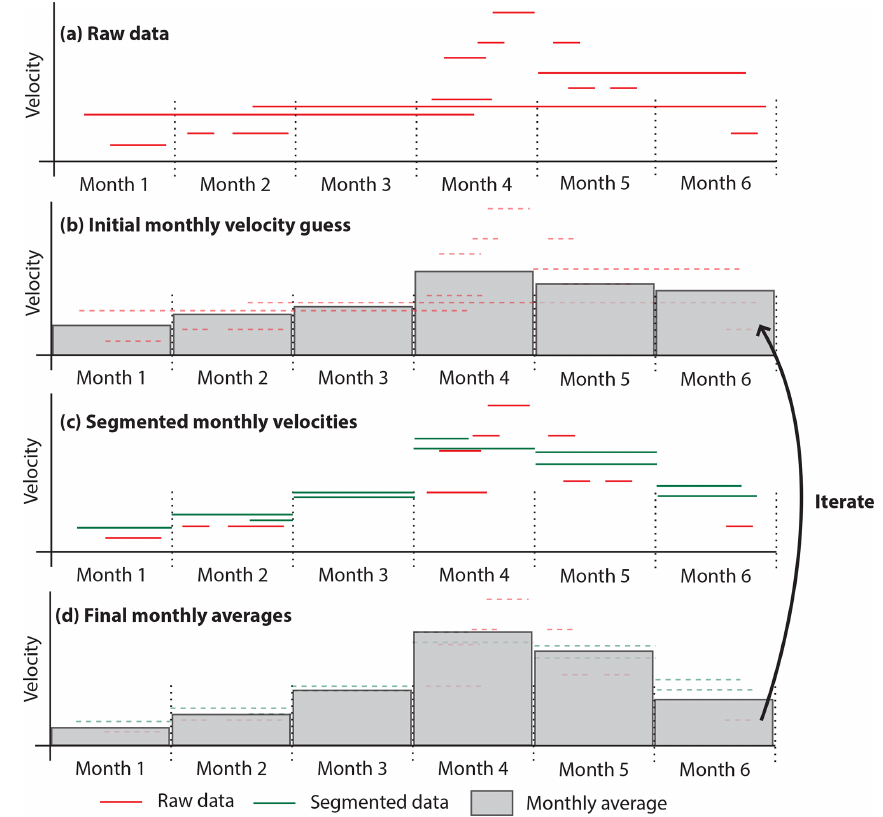
Figure 4. Schematic description of the techniques used to derive monthly velocities. The raw data (a) are combined in a weighted average to make an initial guess of monthly averages (b) . The monthly averages are then used to segment longer time period velocity maps into their different monthly contributions (c) . These are used to recalculate the monthly averages (d) . Finally, GIV iterates over steps (b–d) for a number of times (e.g. 10) provided by user inputs. Note that an estimate may be made for the average velocity in “Month 3” despite this month having no imagery